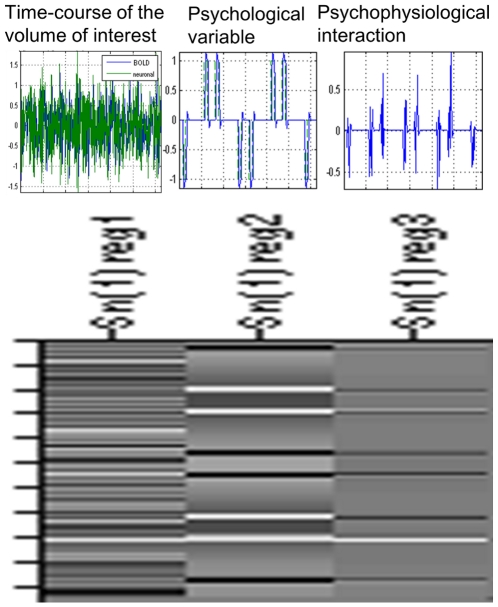
The schema of the design matrix used for PPI analysis of one session.The left column and left figure represent the time-course of the volume of interest (in case of analysis in this study, the right DLPFC). The middle column and middle figure represent the psychological variable (the effect of WM-specific speed; {(2-back Fast−2-back Slow)−(0-back Fast−0-back Slow)}. The right column and right figure represent PPI.